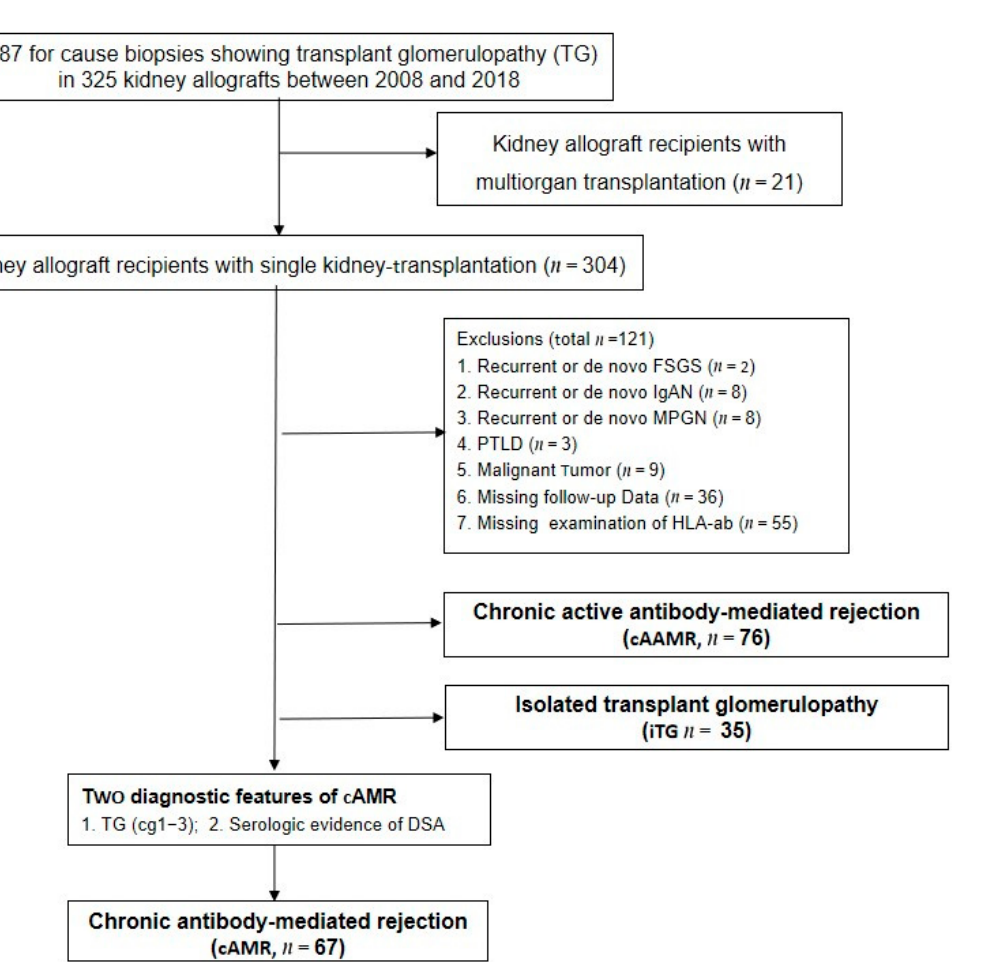
Figure 1. Flow chart of patients enrolled in the study. iTG: isolated transplant glomerulopathy; cAMR: chronic antibody-mediated rejection; cAAMR: chronic active antibody-mediated rejection; PTLD: post transplant lymphoproliferative disorder; IgAN: IgA Nephropathy; FSGS: focal segmental glomerulosclerosis; HLA-ab: antibody against human leukocyte antigen; TG: transplant glomerulopathy; DSA: donor specific anti-HLA antibody